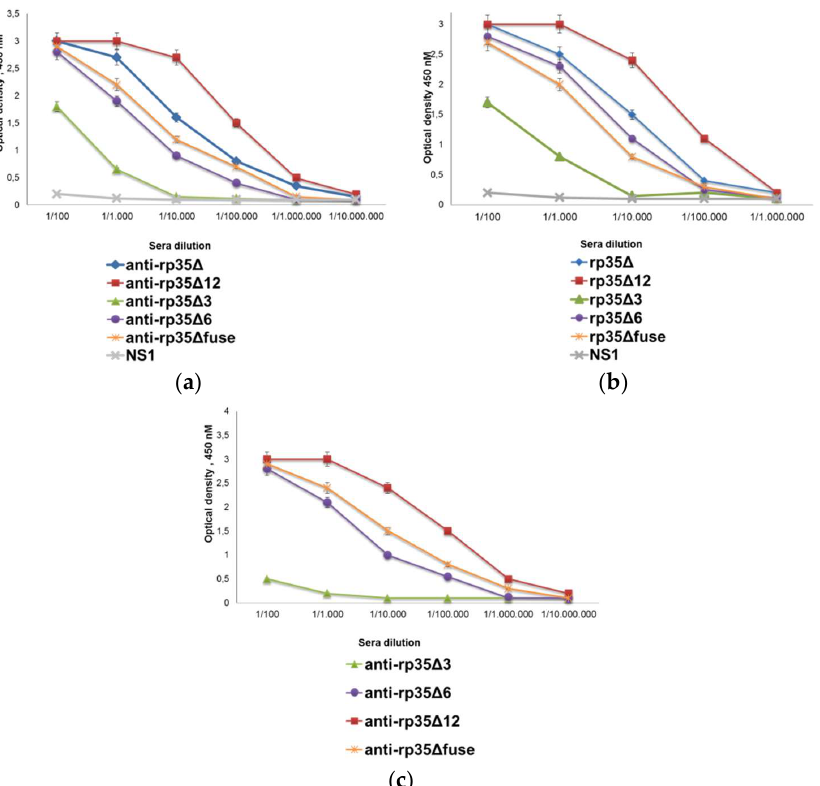
Figure 2. Reactivities of obtained sera samples: ( a ) Indirect ELISA evaluating binding of pooled anti-rp35Δ, anti-rp35Δ3, anti-rp35Δ6, anti-rp35Δ12, and anti-rp35Δfuse sera with the corresponding immunogen; ( b ) indirect ELISA evaluating binding of pooled anti-rp35Δ sera with rp35Δ, rp35Δ3, rp35Δ6, rp35Δ12, and rp35Δfuse; ( c ) indirect ELISA evaluating binding of pooled anti-rp35Δ3, anti-rp35Δ6, anti-rp35Δ12, and anti-rp35Δfuse with rp35Δ. Tick-borne encephalitis trx-NS1 was used as a control of nonspecific binding. Absorbance was measured at 450 nm. Pooled serum samples obtained from mice immunized with rp35Δ, rp35Δ6, rp35Δ12,